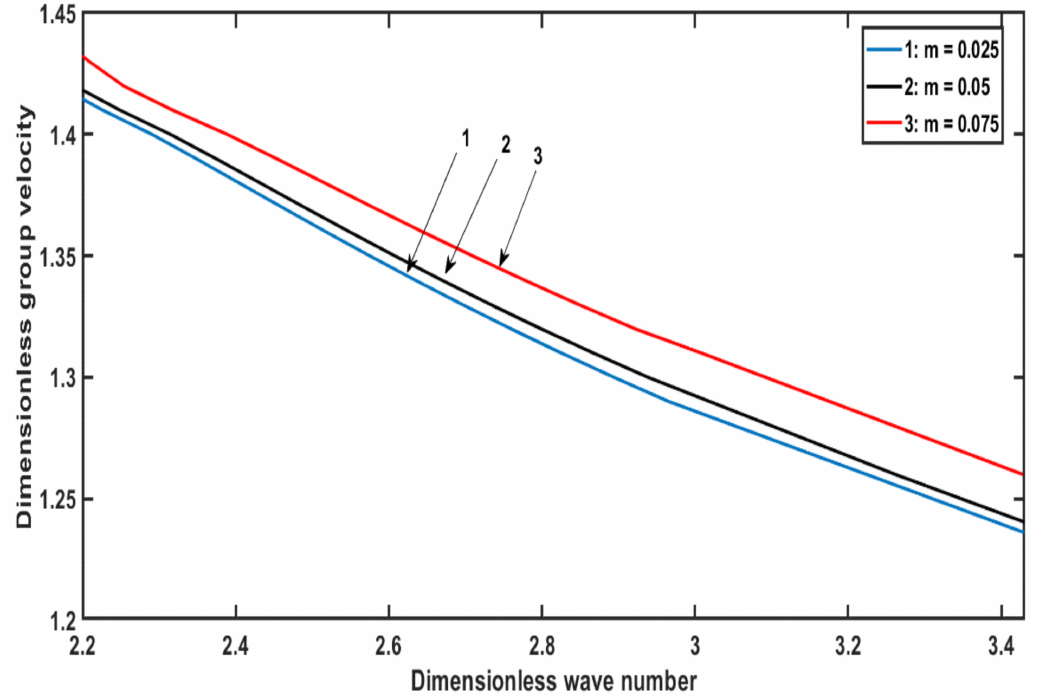
Figure 10. The group velocity with wave number when a 1 = 0.1, p = 0.01, a 2 = 0.2, h = 0.01, α = 0.2, β =